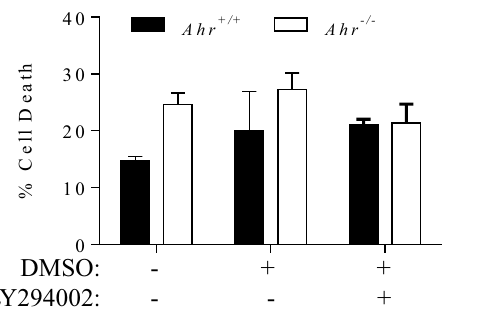
Figure 7. Effect of LY294002 on cell viability. Ahr +/+ and Ahr −/− MLFs were either treated with LY294002 or an equivalent volume of DMSO for 24 h and viability was assessed by MTT assay, trypan blue exclusion and PI/ flow cytometry ( A ) -There was a significant reduction in MTT reduction in Ahr −/− MLFs treated with LY294002. Results are expressed as percent viability relative to the untreated Ahr +/+ cells and are presented as mean ± SEM (n = 5 independent experiments; *p < 0.05 and **p < 0.01 compared to corresponding DMSO control and media- only cells, respectively). ( B ) There was no significant reduction in cell viability upon treatment with LY294002 in either Ahr +/+ and Ahr −/− MLFs. ( C ) Representative flow cytometry histograms of Ahr +/+ and Ahr −/− MLFs treated with DMSO or LY294002; percentage of dead cells is indicated. ( D ) There was no significant increase in the percentage of dead cells in response to LY294002. Results are presented as the mean ± SEM (n = 2–5 independent